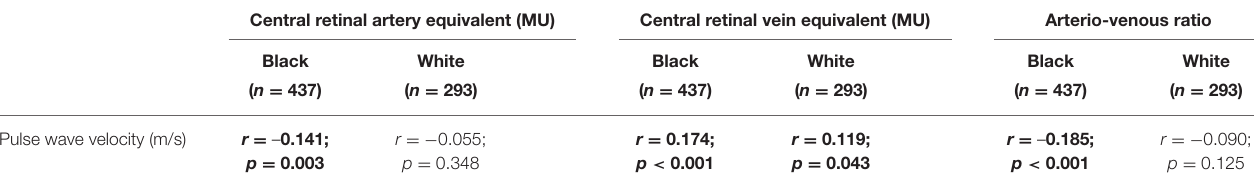
TABLE 2 | Partial correlations between large artery stiffness and retinal calibers in children stratified according to ethnicity. Central retinal artery equivalent (MU) Central retinal vein equivalent (MU) Arterio-venous ratio Black White Black White Black White ( n = 437) ( n = 293) ( n = 437) ( n = 293) ( n = 437) ( n = 293) r = 0.174; r = − 0.055; Pulse wave velocity (m/s) r = – 0.141; p = 0.003 p < p = 0.348